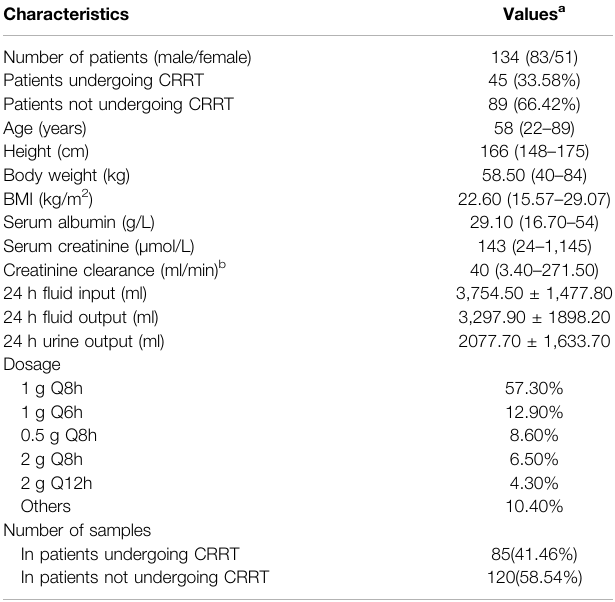
TABLE 1 | Clinical characteristics of the external